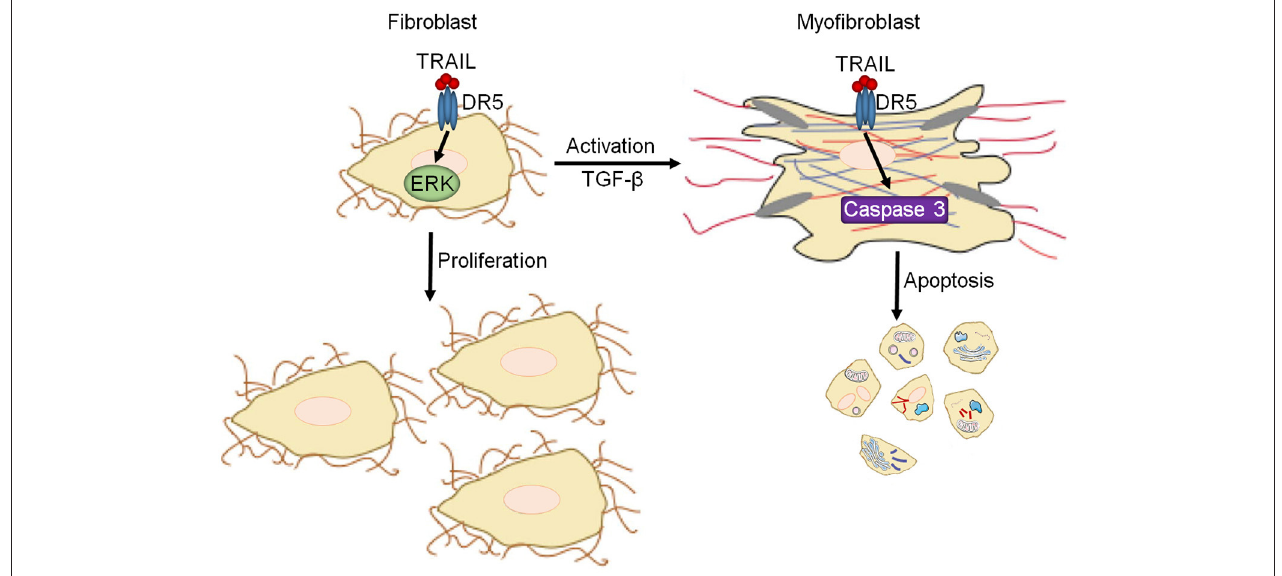
FIGURE 7 | Summary of DR5 in cardiac fibroblasts. In naïve cardiac fibroblasts, DR5 activates ERK1/2 resulting in increased proliferation. Upon differentiation/activation of cardiac fibroblasts to myofibroblasts, DR5 signaling changes to a canonical DR5 signaling paradigm leading to caspase activation and cell